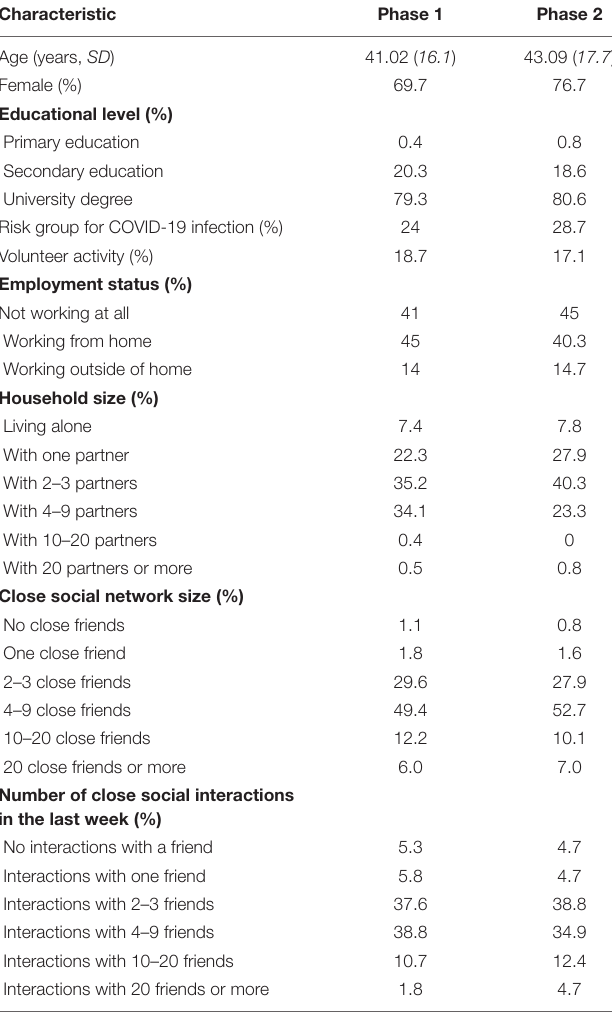
TABLE 1 | Demographic characteristics of the sample in the first and second